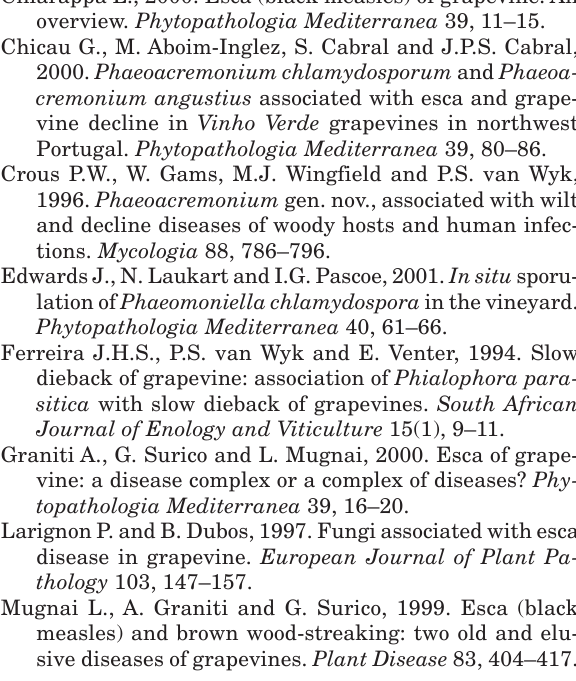
Fig. 2. Map of 4-year-old Cabernet Sauvignon vines (left) and Merlot vines on Kober 5BB rootstock (right) (Site 2) expressing esca foliar symptoms. Grey squares: symp- tomatic in year 2000; black squares: symptomatic in year 2001; (cid:1) : missing